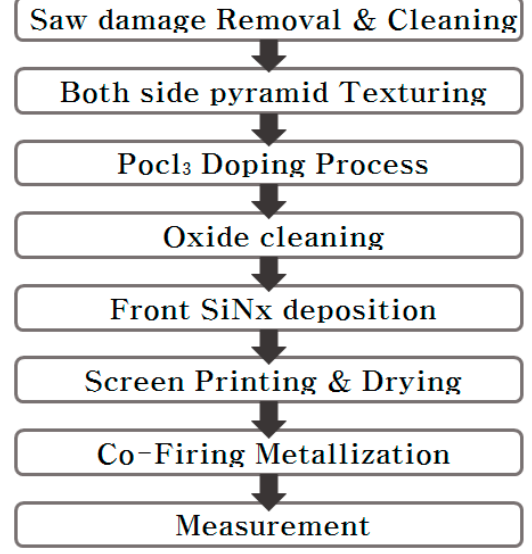
Figure 5. Solar cell fabrication sequence.